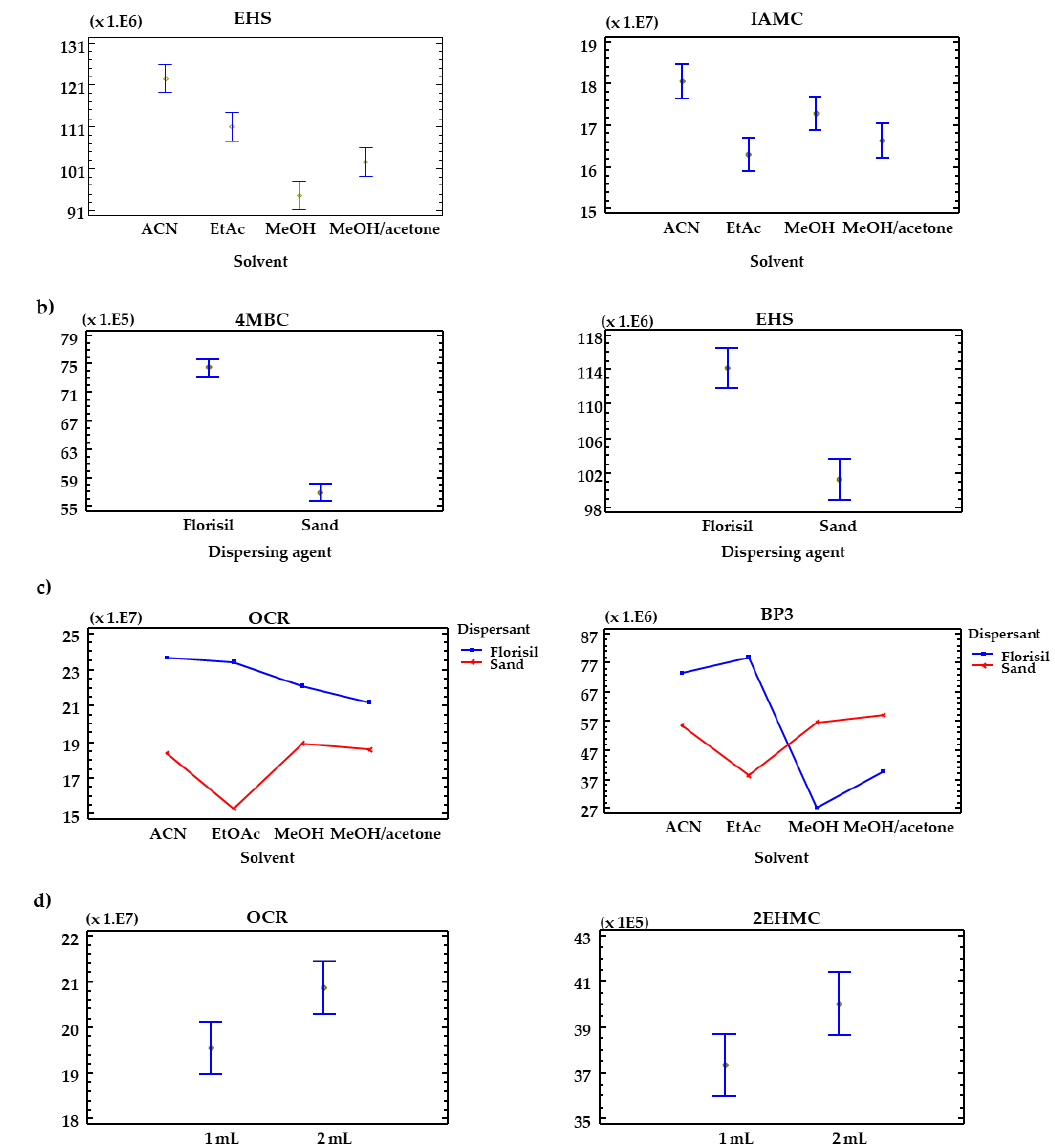
Figure 2. Mean plots ( a , b , d ) and interaction plots ( c ) of the main factors studied in the multi-factor categorical design for some representative ultraviolet (UV) filters .